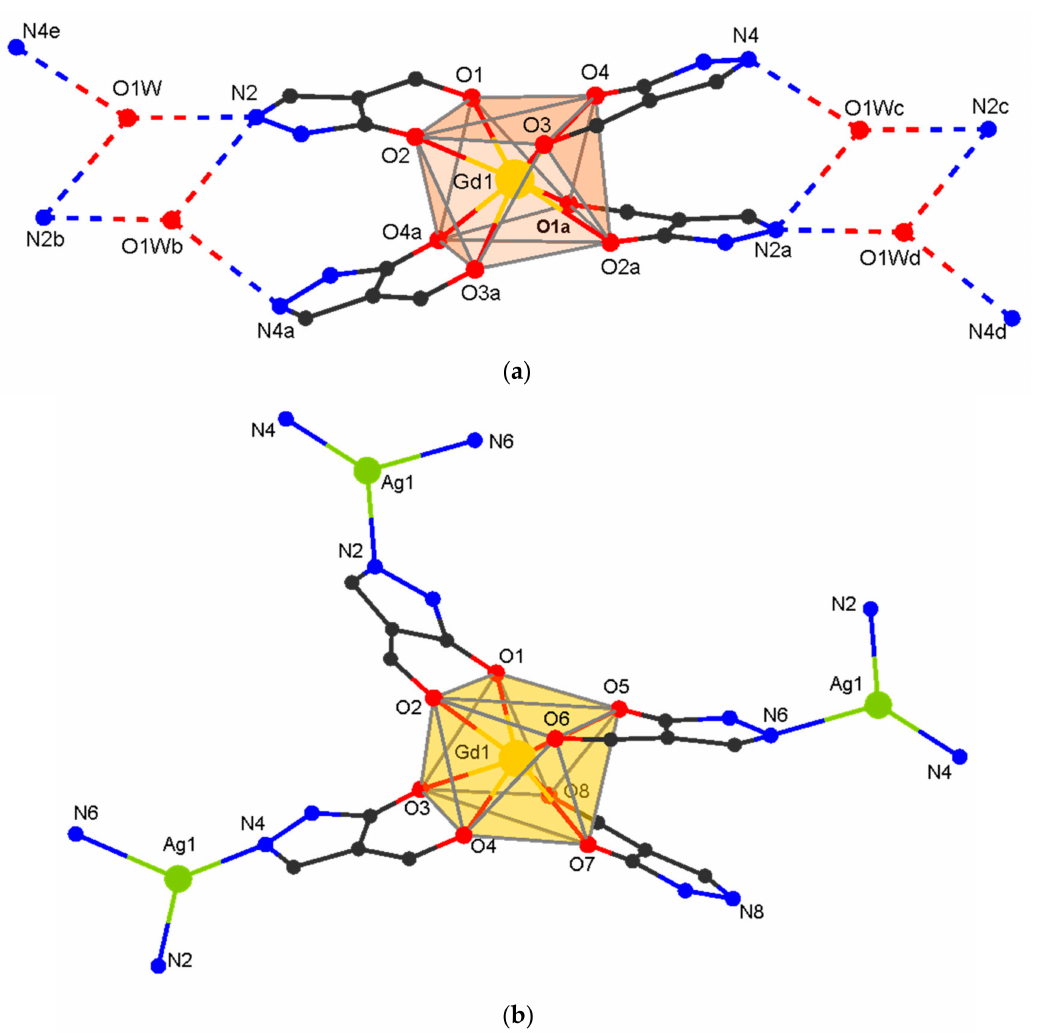
Figure 2. Fragment of the crystal packing in H 3 O[Gd(Q cy ) 4 ] 3 ( a ) and [AgGd(Q cy ) 4 ] n 8 ( b ) (phenyl, cyclohexyl and methyl groups are omitted for